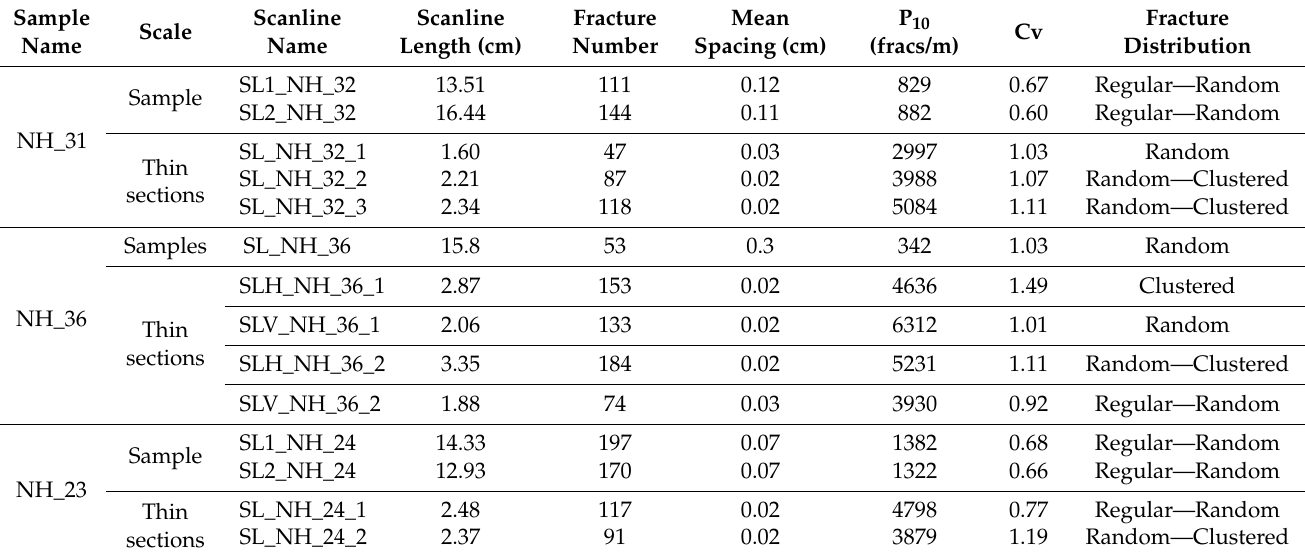
Table 2. Spatial fractures analysis. Scanline length: total length of each scanline; fracture number, mean spacing, P 10 , and Cv value by scanline and fracture distribution tendency by